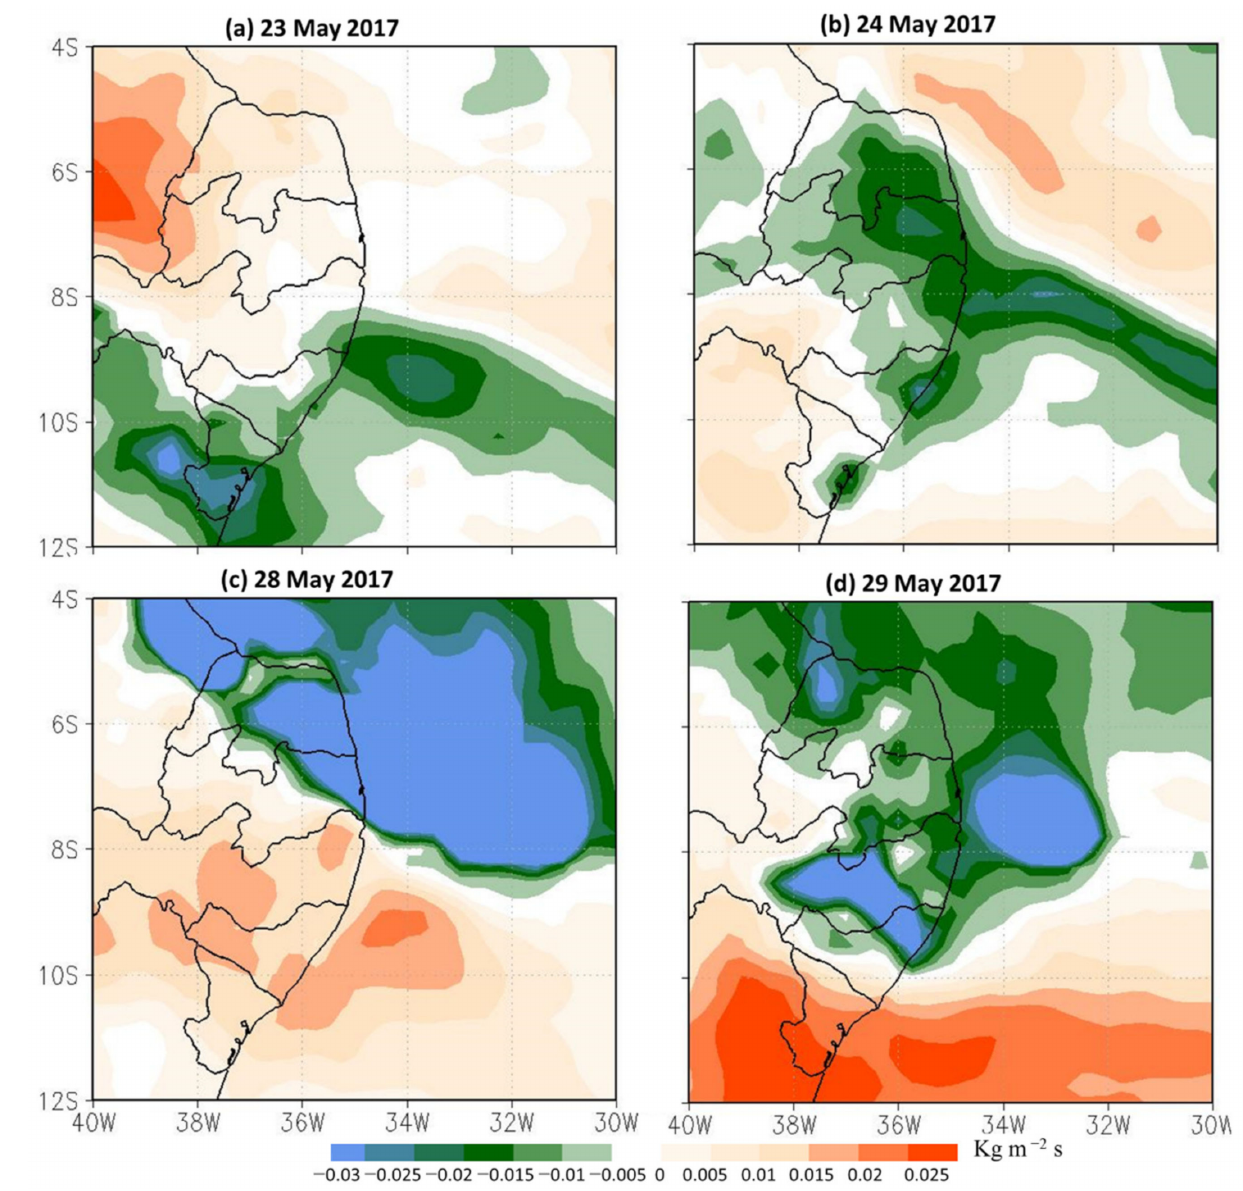
Figure 13. Average daily fields of vertically integrated moisture flux convergence (kg m − 2 s). The information corresponds to 24 ( a ), 25 ( b ), 28 ( c ), and 29 ( d ) May